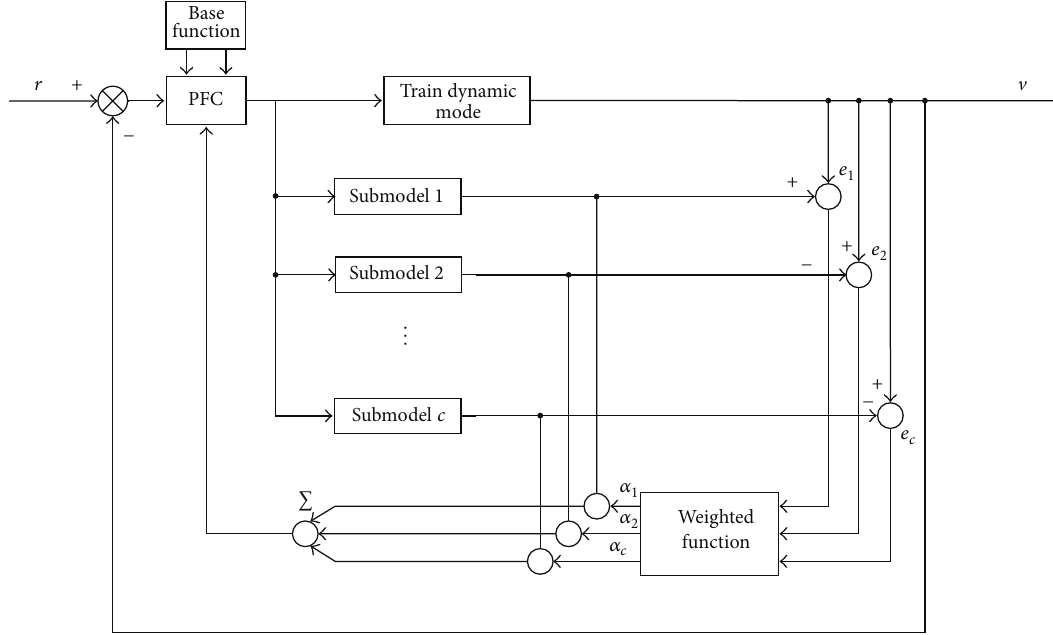
Figure 1: The structure of multimodel weighted predictive function control for